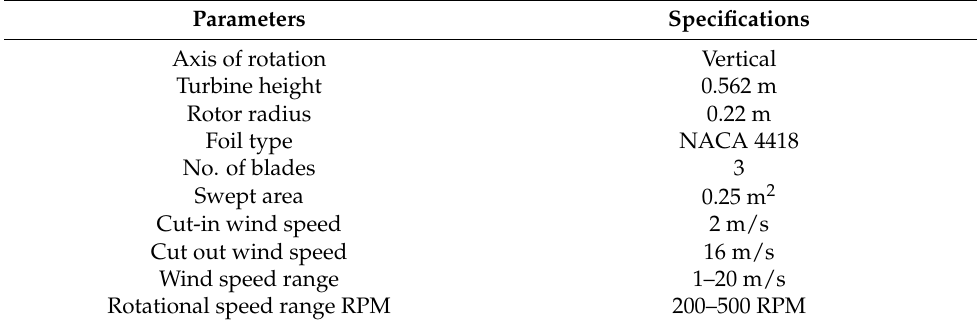
Table 1. VAWT specifications.